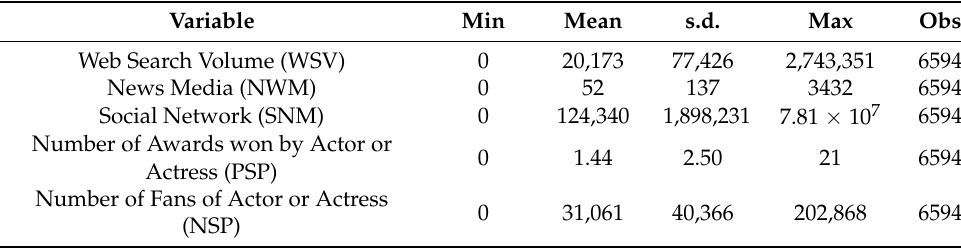
Table 1. Descriptive statistics of key variables.